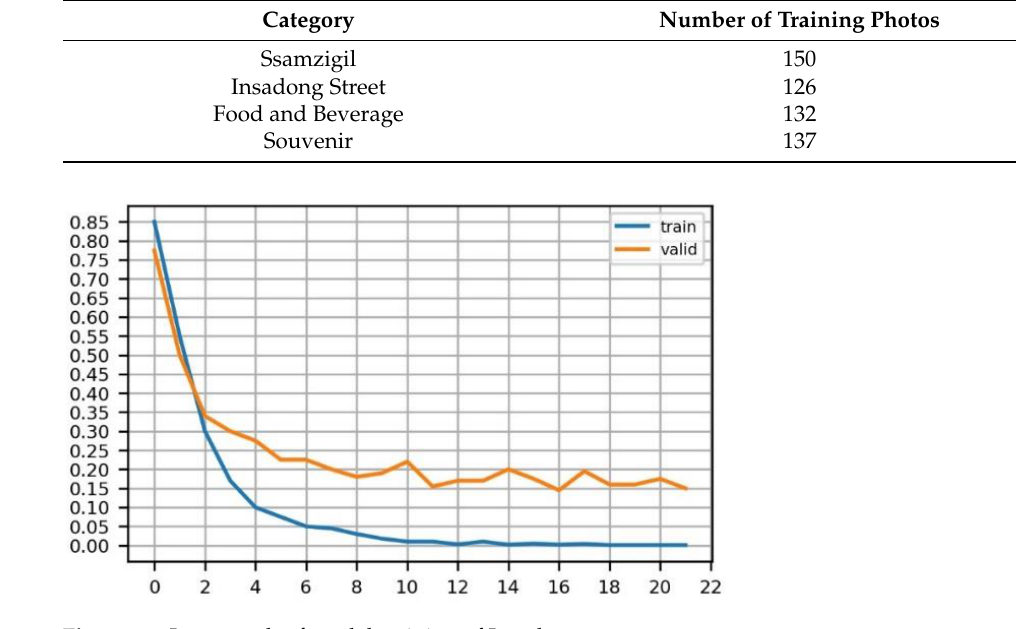
Figure 14. ROC curve of Insadong.